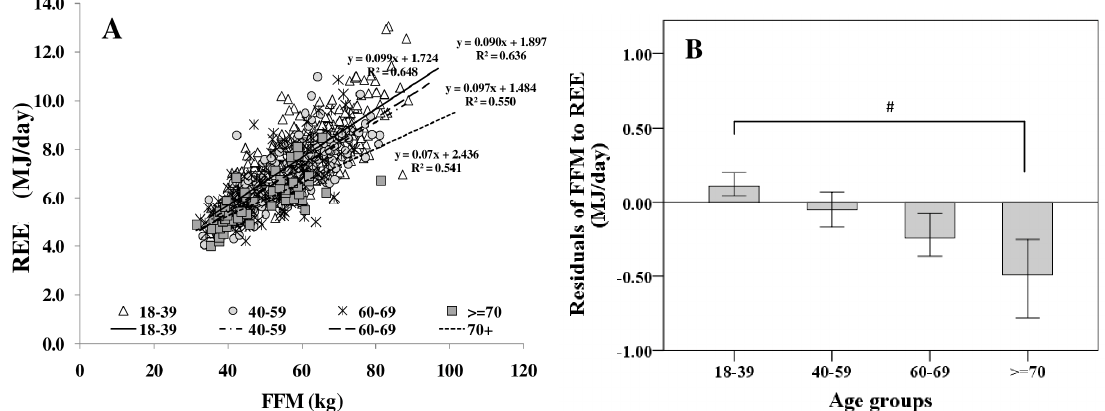
Figure 1. Age ‐ dependent decrease in fat free mass (FFM) ‐ resting energy expenditure (REE) relationship ( A ) and their residuals in different age groups (median; 95% CI) ( B ). Significant differences between age ‐ groups are indicated by # as tested by Kruskal ‐ Wallis ‐ test ( n = 714). FFM was assessed by Air Displacement Plethysmography (ADP) (for details, see Methods).